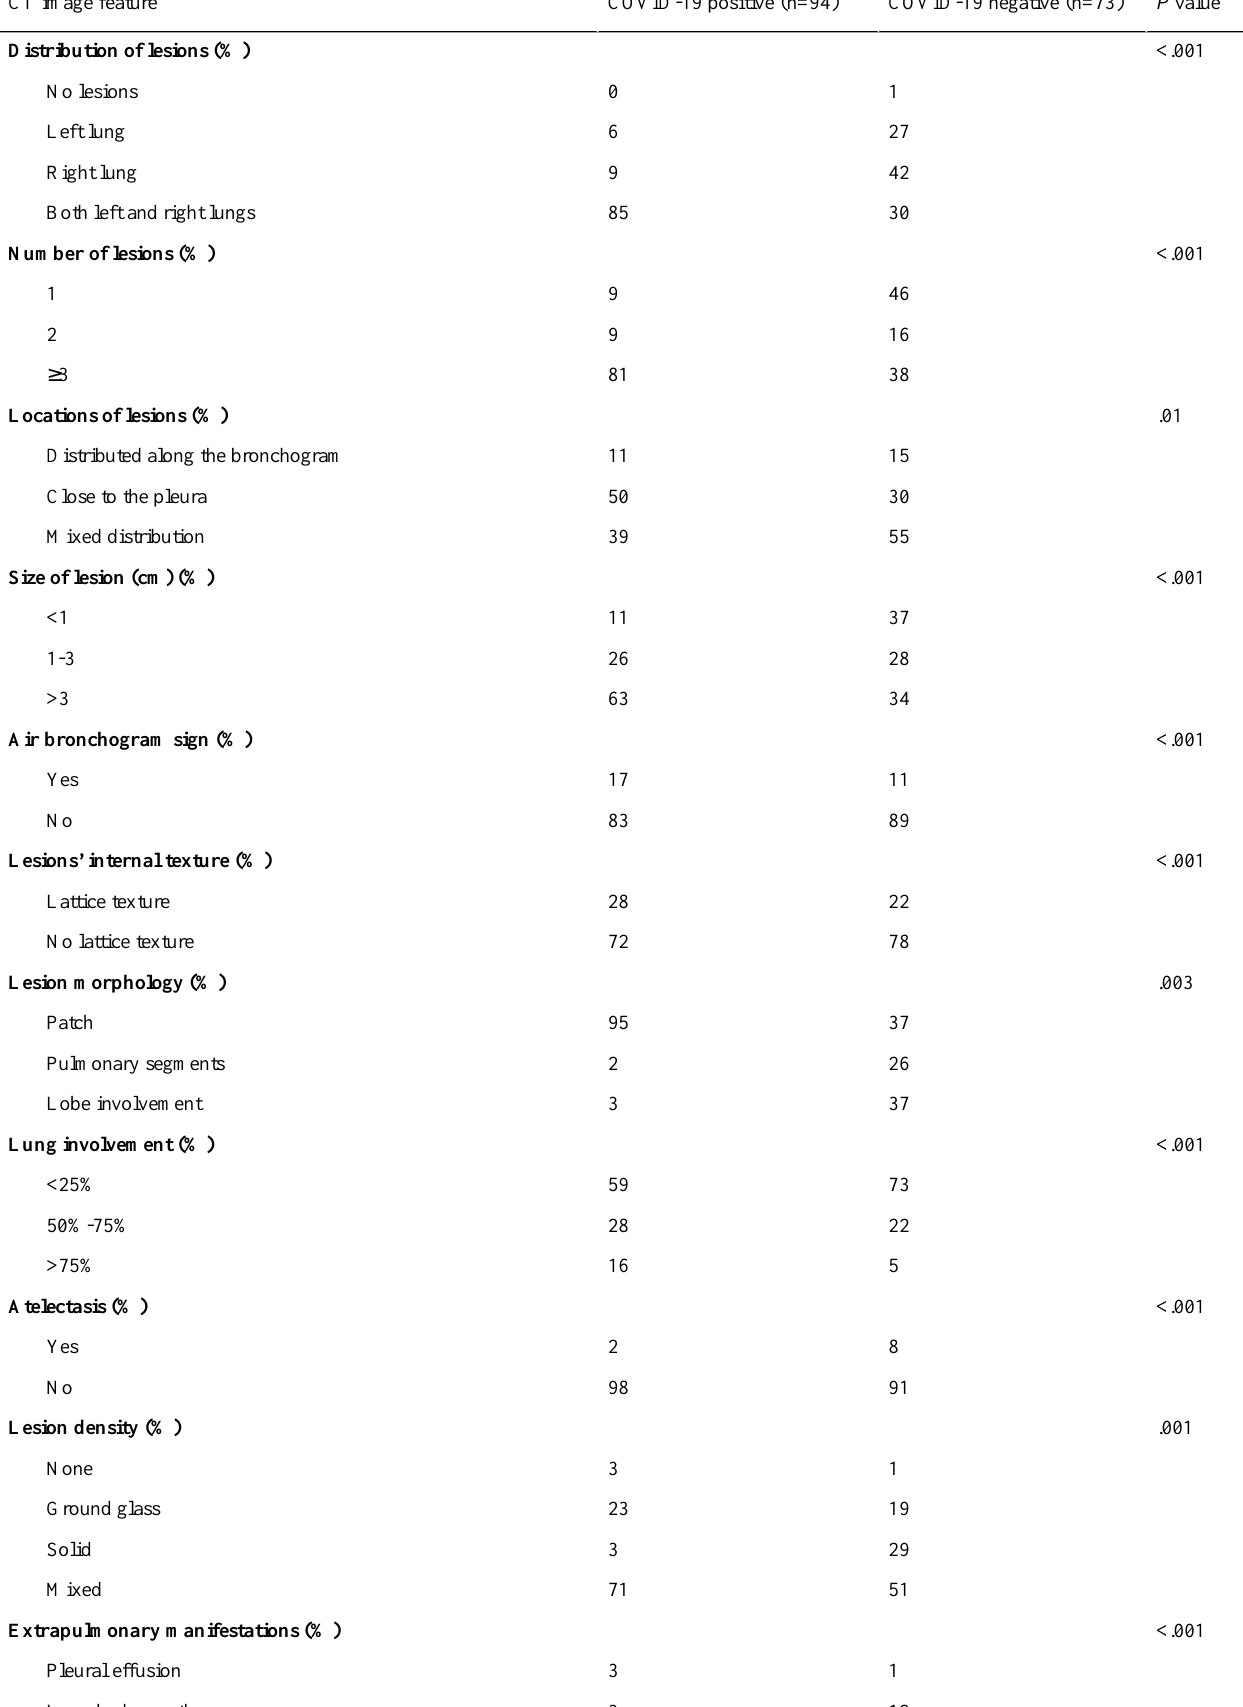
Table 3. Chest computed tomography (CT) results with lesions and imaging